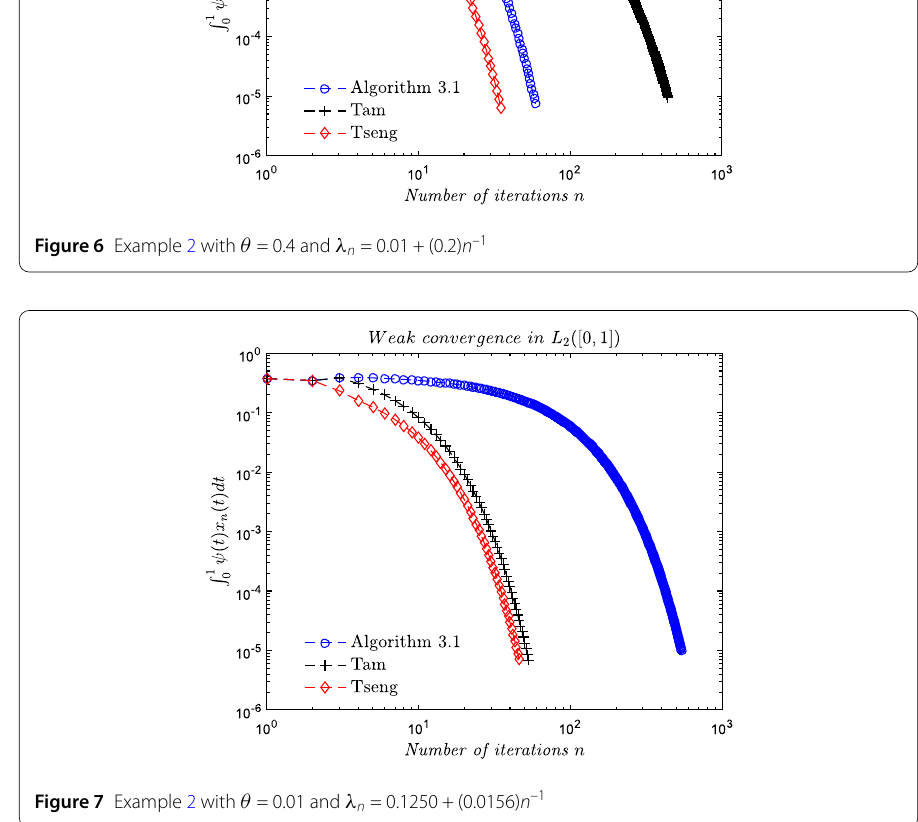
Figure 7 Example 2 with θ = 0.01 and λ n = 0.1250 + (0.0156) n –1